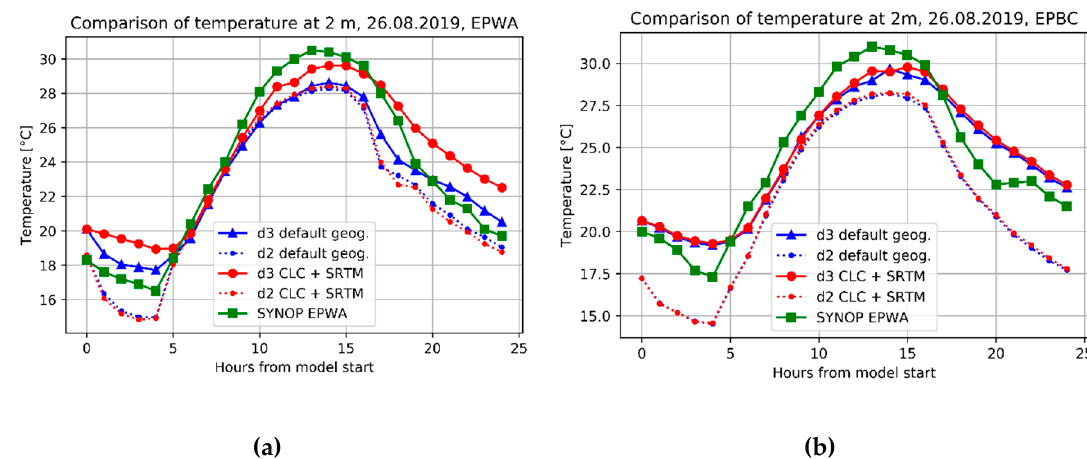
Figure 5. Example of the obtained values of temperature at 2 m (AGL) for 26.08.2019 at the airport ( a ) 318 EPWA; ( b ) EPBC. 319 EPWA; ( b )